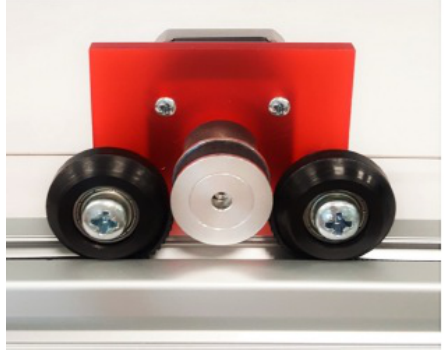
Fig. 10. Group II ‘s trolley system